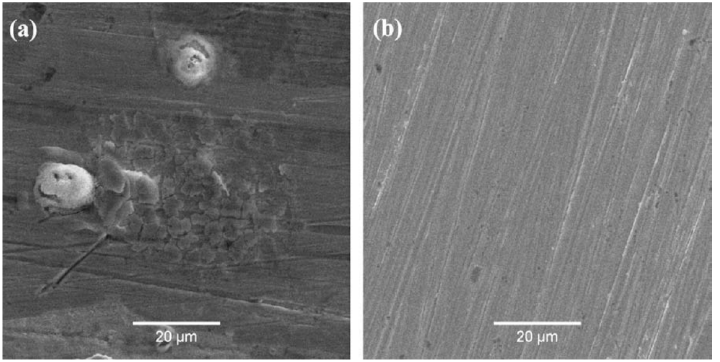
Figure 13. SEM micrographs for ( a ) Fe-Mn-Al-Si, and ( b ) interstitial-free (IF) steel after polariza- tion experiments in 0.1 M H 2 SO 4 [108]. (Reproduced with permission from refs. [108] . Copy- right (2008 ), Elsevier).